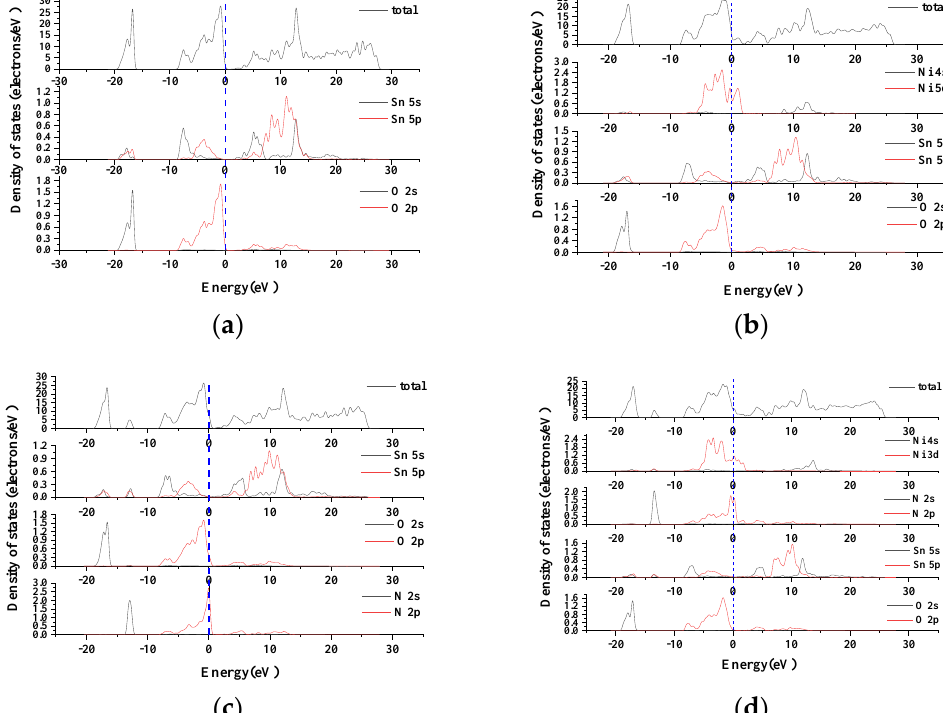
Figure 3. Density of states: ( a ). SnO 2 ; ( b ). SnO 2 – Ni; ( c ). SnO 2 – N; ( d ). SnO 2 – Ni – N.